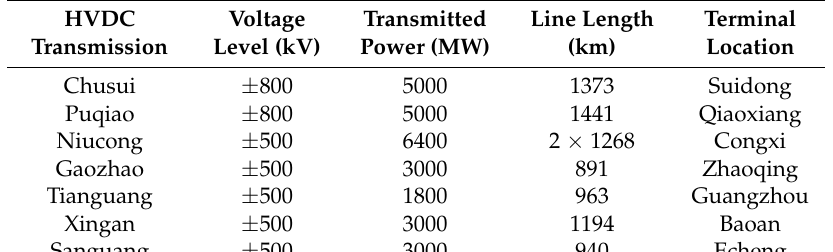
Table 3. HVDC transmission lines in the China Southern Power Grid.